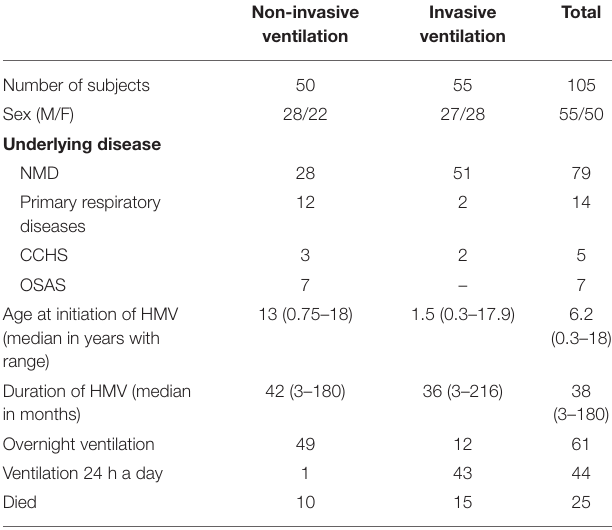
TABLE 1 | Demographic